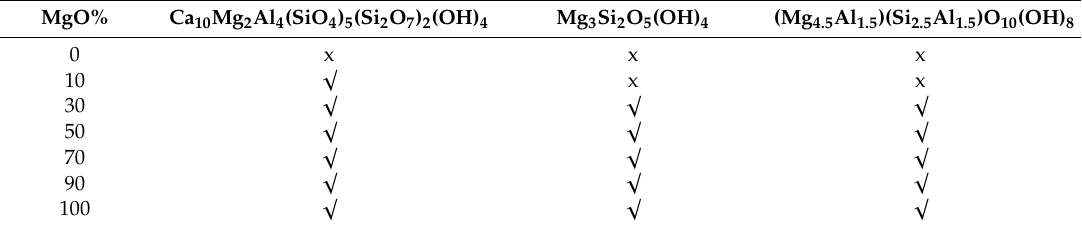
Table 3. XRD patterns of the solid products at 200 ◦ C.